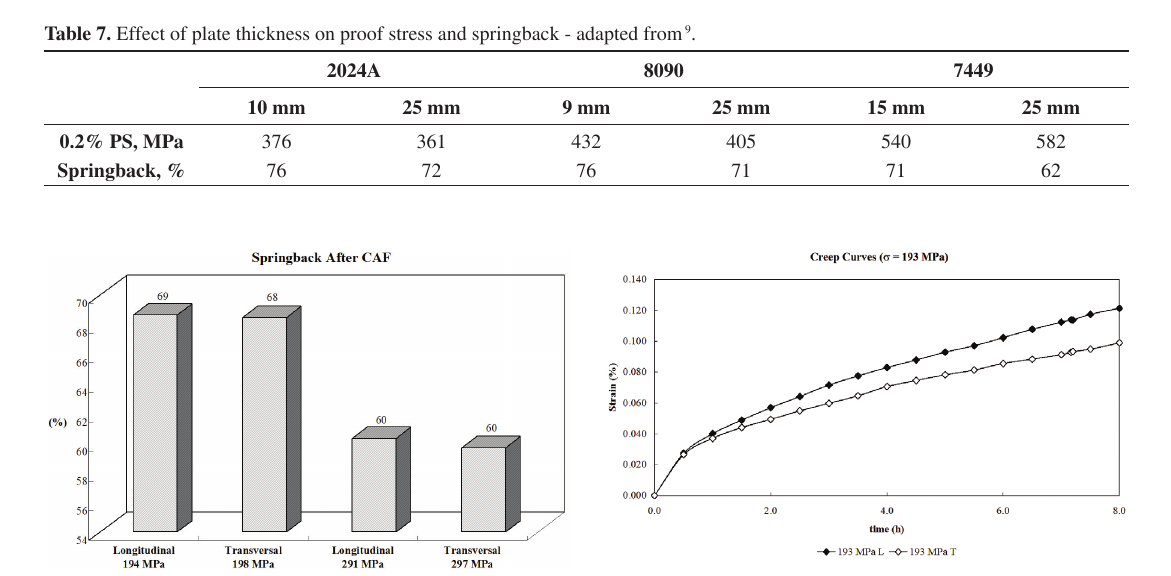
Figure 16. Creep curves at 193 MPa for AA7050-TAF (first and second stages observed),